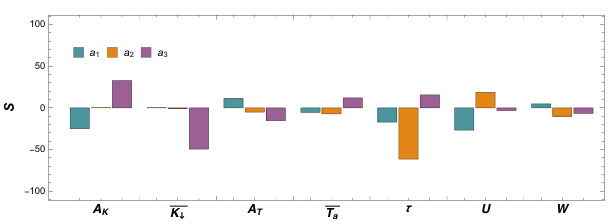
Figure 4. Relative variation in sensitivity ( S , %, Eq. 28) to forcing parameters. See Fig. 3 for further